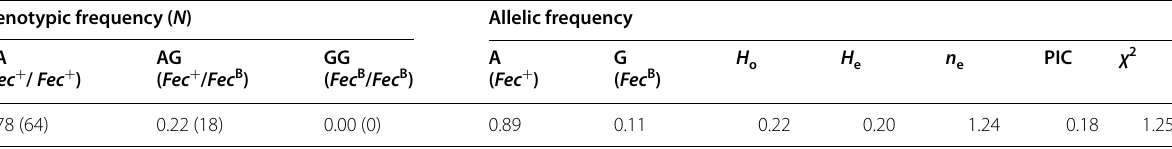
N number of observation, H o observed heterozigosity, H e expected heterozygosity, n e number of effective allele, PIC polymorphic informative content, χ 2 chi-square value * Under Hardy–Weinberg equilibrium